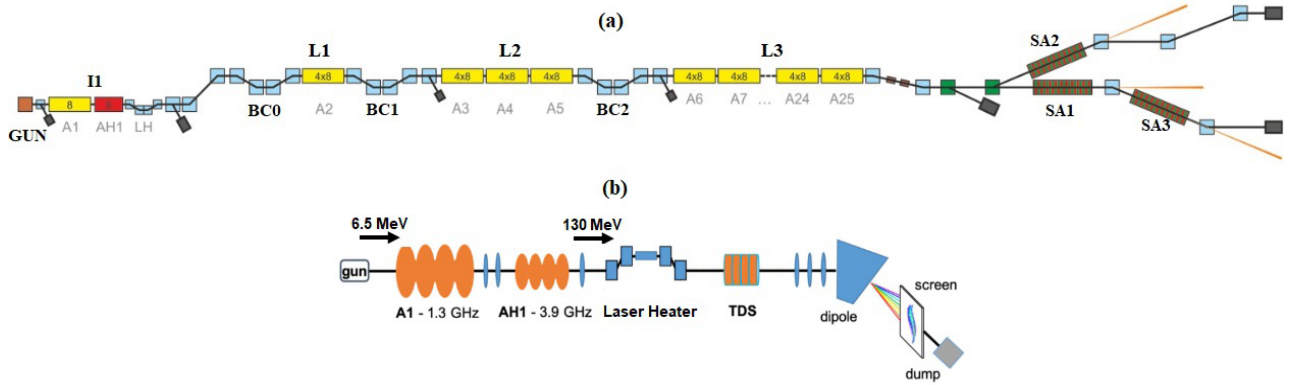
Figure 1. Sketch of the European XFEL: ( a ) machine layout; ( b ) injector section layout. [GUN: electron gun; I1: injector section; L1, L2 and L3: the first, second and third (main) acceleration section; BC0, BC1 and BC2: the first, second and third bunch compressors; SA1 and SA2: two hard X-ray undulator beamlines; SA3: a soft X-ray undulator beamline; A i , i = 1:25 denotes 25 RF stations; AH1 stands for a 3.9 GHz module; TDS: transverse deflecting